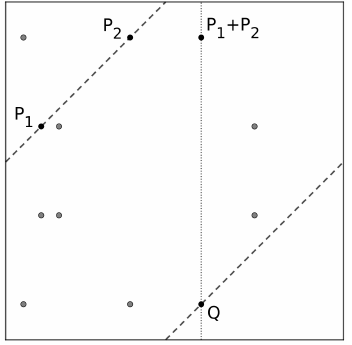
Figure 1. Chord-tangent sum over finite